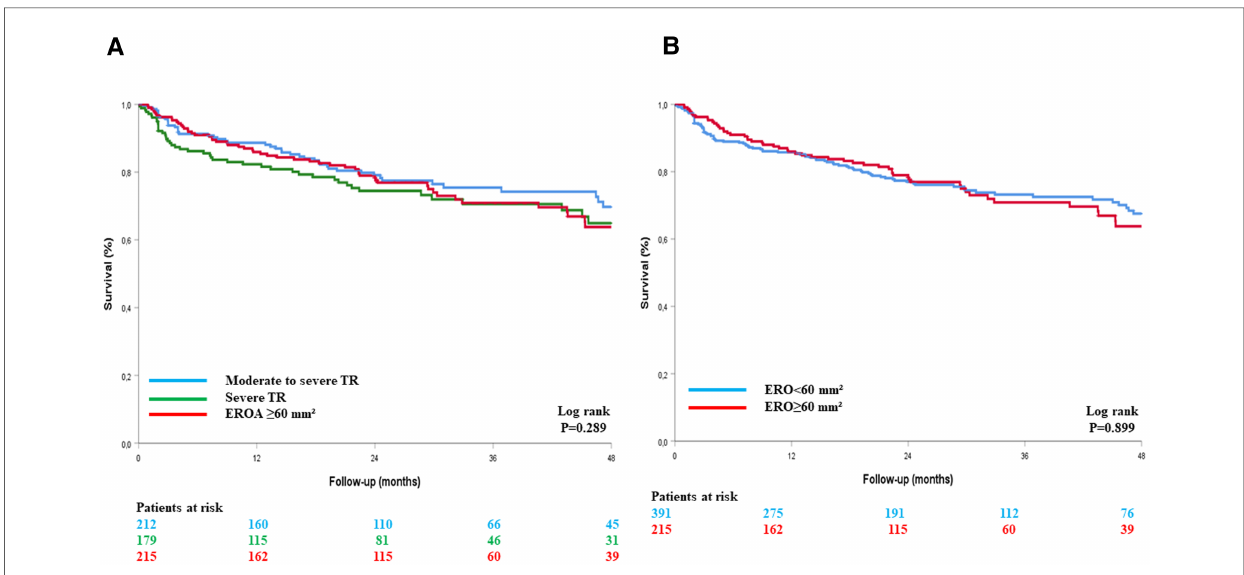
FIGURE 2 Kaplan – Meier survival curves of patients with TR, with VSTR de fi ned by an EROA ≥ 60 mm 2 , in three groups ( A ) and in two groups ( B ). EROA, effective regurgitant ori fi ce area; TCG, tricuspid coaptation gap; TR, tricuspid regurgitation.